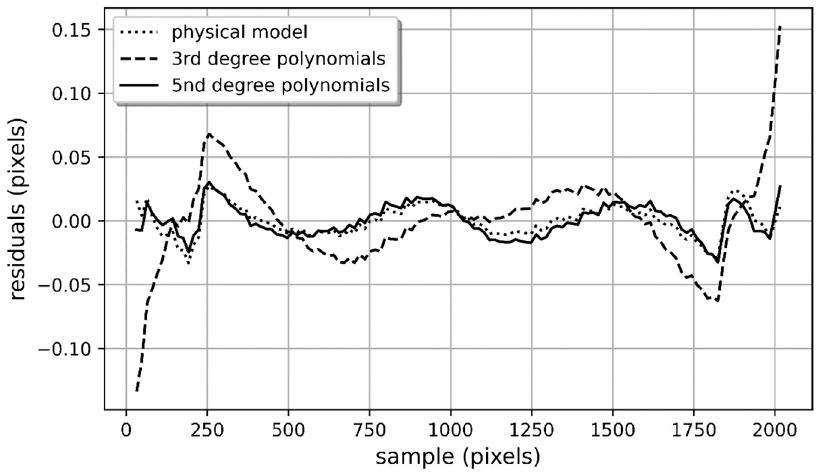
Figure 6. Residuals of co-registration models for B1B8 in the along-track direction.